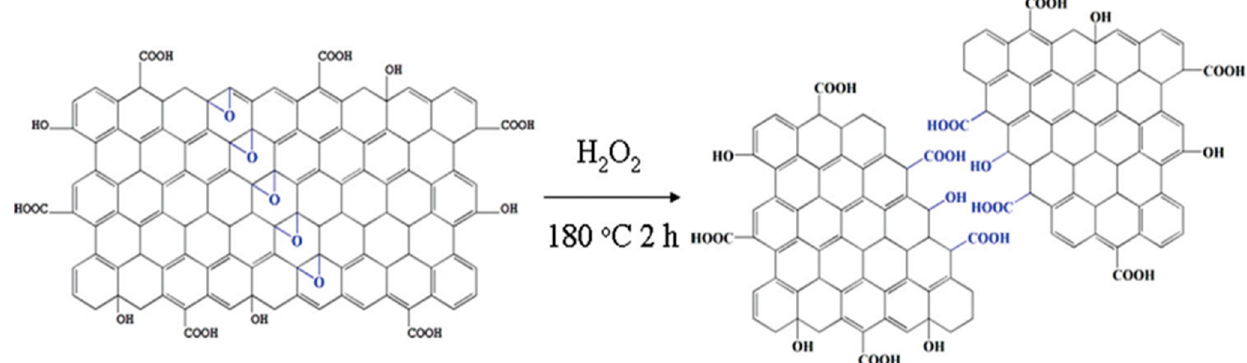
Figure 2. Rapid hydrothermal cutting of GO into GQDs. Superoxide anions assisted in cutting the C–C bond of vicinal diol. Reprinted with permission from Ref. [37].